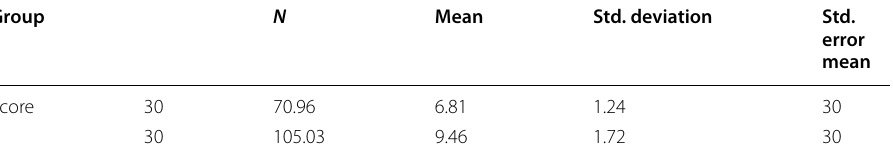
Table 28 Learner autonomy post‑test descriptive statistics Group N Mean Std.